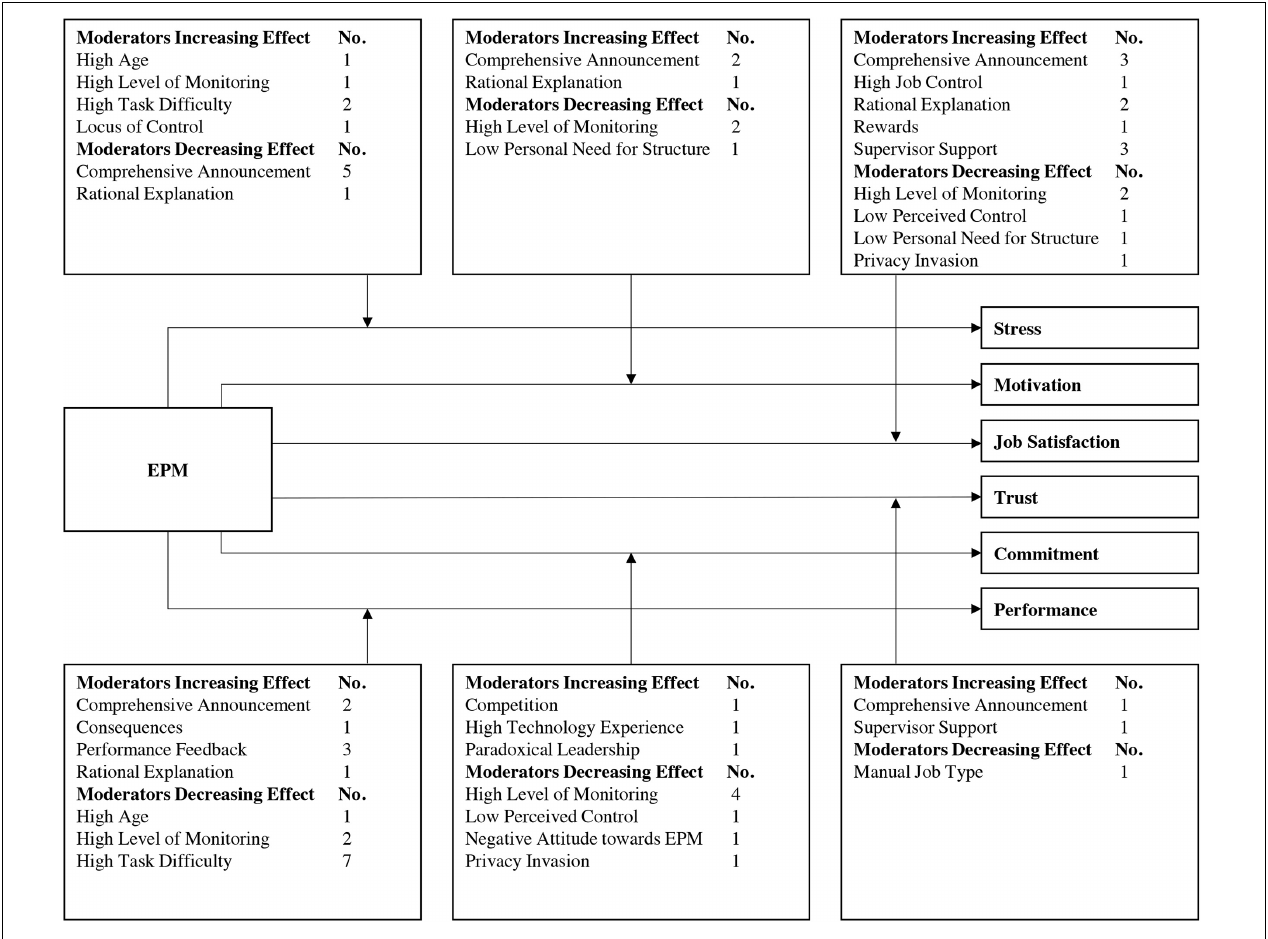
FIGURE 3 | EPM research model with focus on moderation